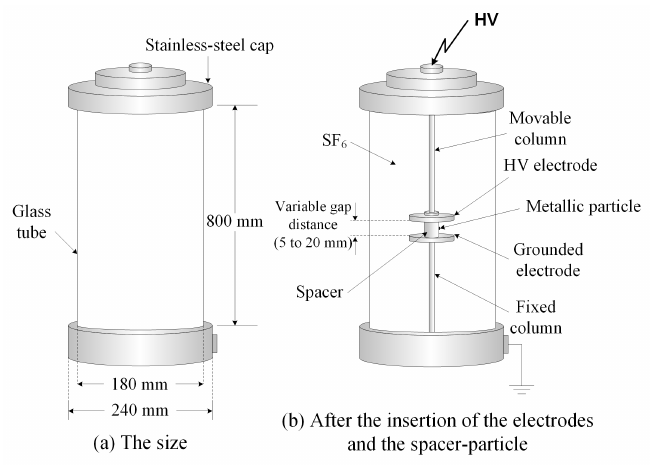
Fig. 1. The GIS chamber used for the experiment